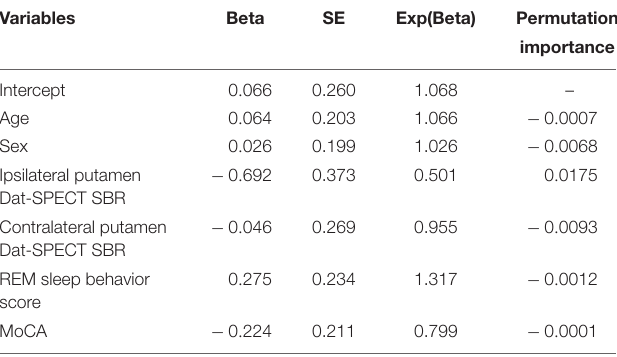
TABLE 2 | Clinically selected model 1 to predict motor progression in individuals with PD.